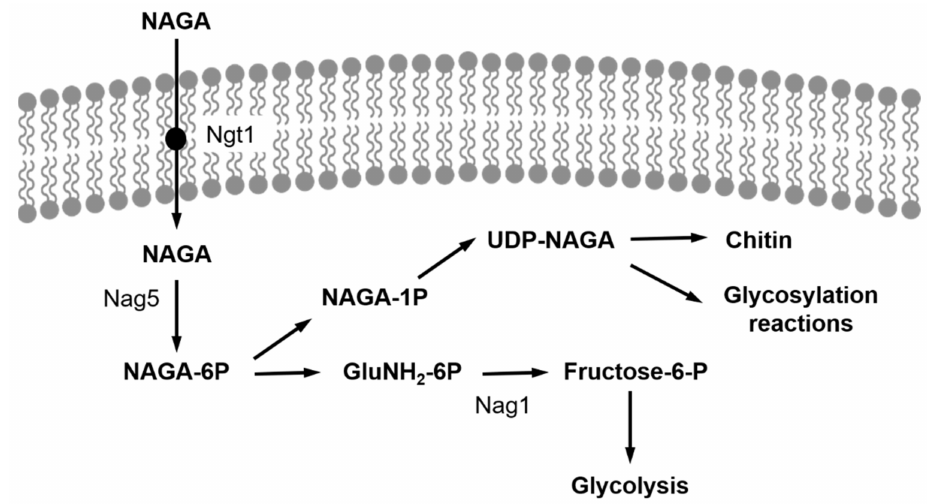
Figure 1. Pathway of NAGA utilization in Y. lipolytica . After its transport by Ngt1, NAGA is phosphorylated by NAGA kinase, Nag5, and channelled to the glycolytic pathway. NAGA-6-P is also an initial metabolite for chitin synthesis and glycosylation reactions. Nag1, glucosamine-6-P